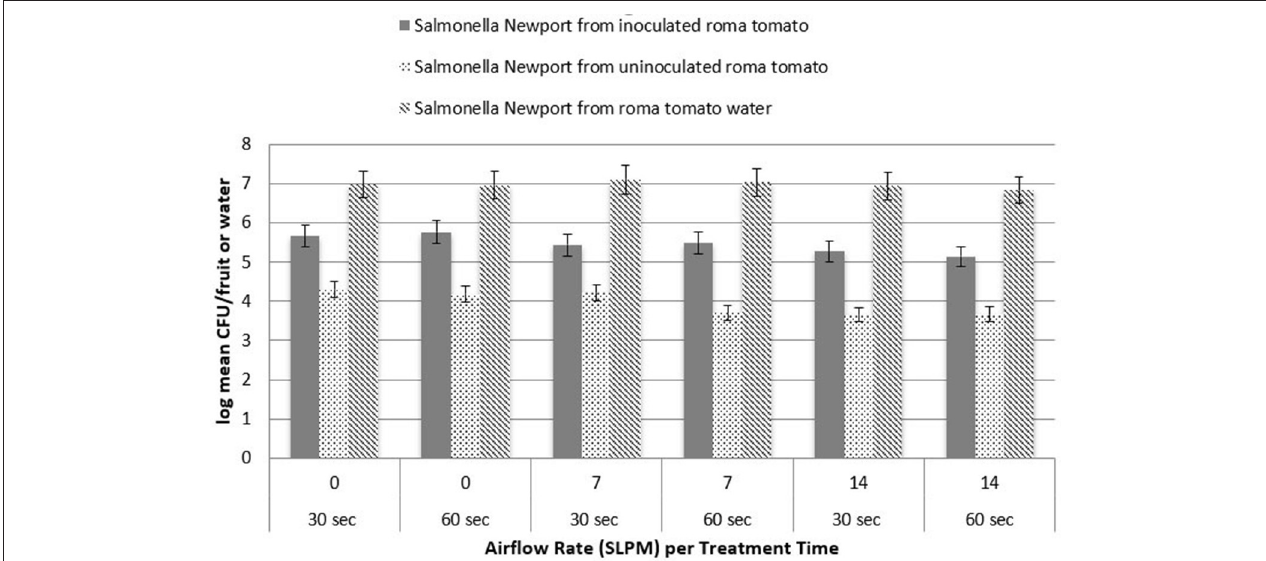
FIGURE 6 | Recovery of Salmonella Newport from inoculated and uninoculated Roma tomatoes, as a function of treatment time ( n = 3).